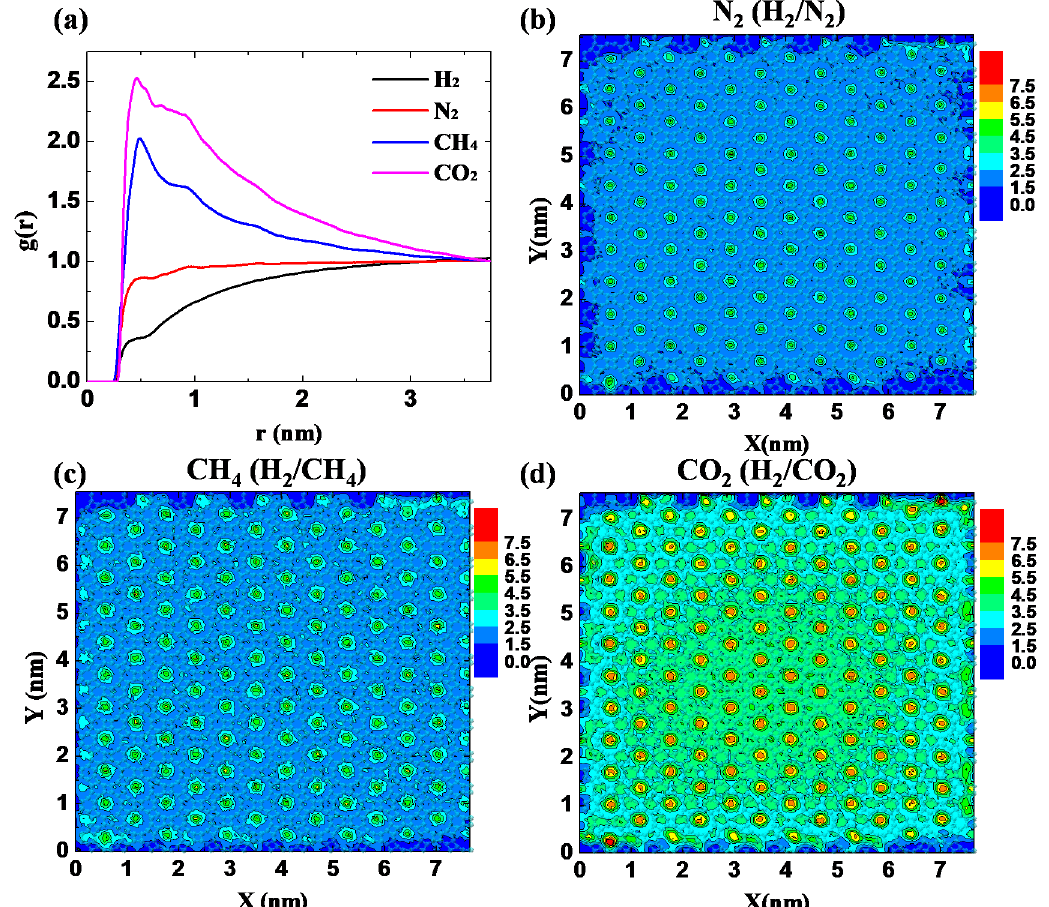
Figure 6. Blocking effect on the surface of GDY_2.1Å. ( a ) Radial distribution function (RDF) of gases around the membrane. Density contours of the impermeable gases on the surface: ( b ) N 2 (H 2 /N 2 ); ( c ) CH 4 (H 2 /CH 4 ); ( d ) CO 2 (H 2 /CO 2 ). The unit of density (N w /uc) is 1/(1.25Å 3 ).